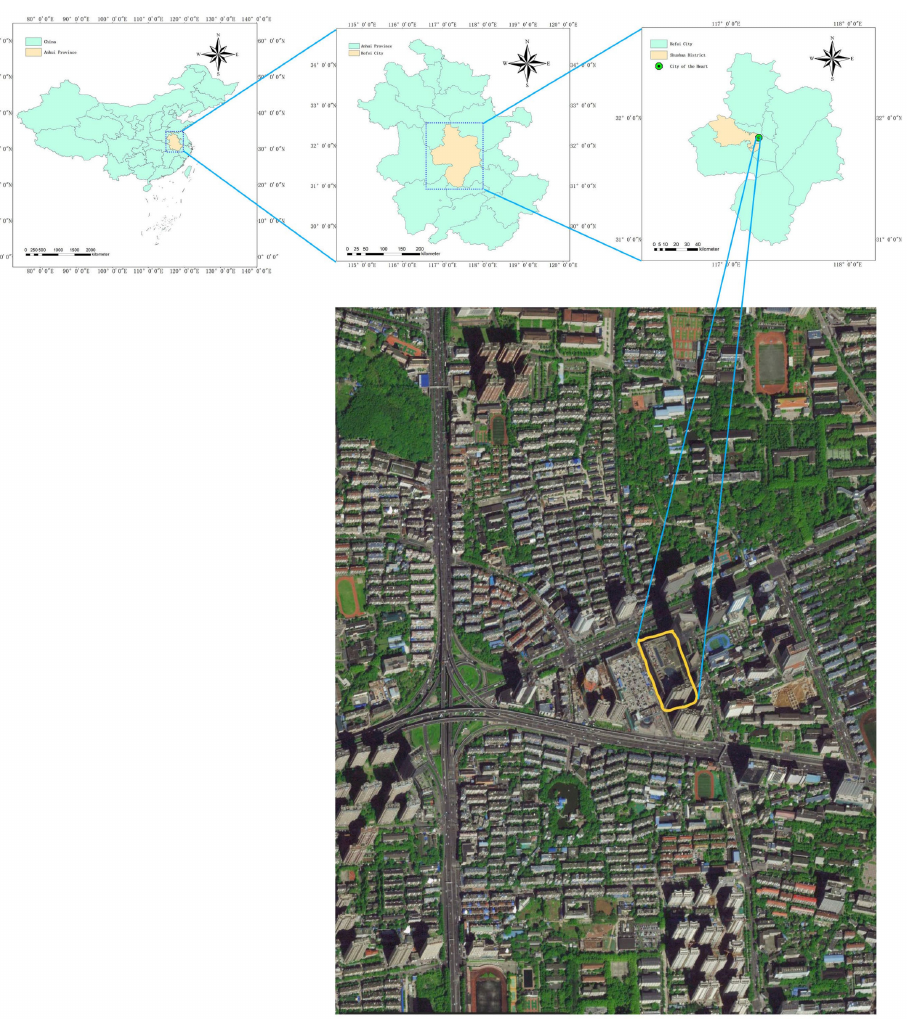
Figure 2. Study area and sampling sites in Hefei